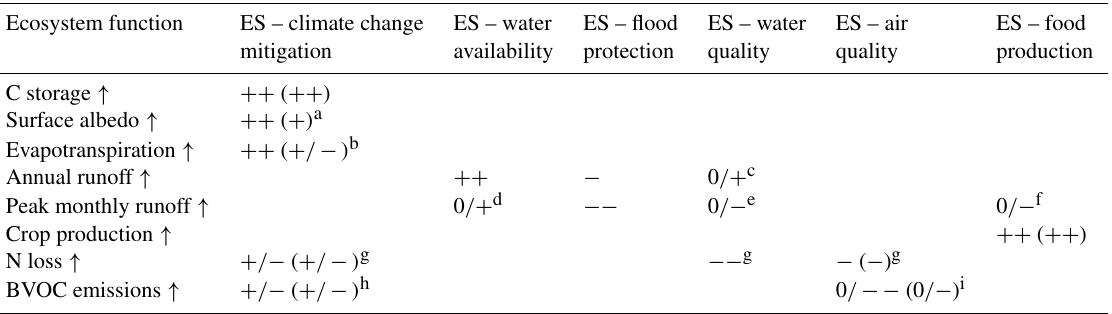
Table 1. Linking ecosystem functions to ecosystem services (ESs). An increase in an ecosystem function can be interpreted positive ( + ), negative ( − ), zero (0), or either positive or negative ( + / − ), depending on the background conditions or perspective. Effects can be small ( + or − ) or large ( ++ or −− ). Regional effects are shown without brackets and global effects, where relevant, in brackets. Indirect effects that are more directly represented by another ecosystem function considered here are not shown. The table is based on evidence from the literature in cases where the link is not directly clear (see footnotes).